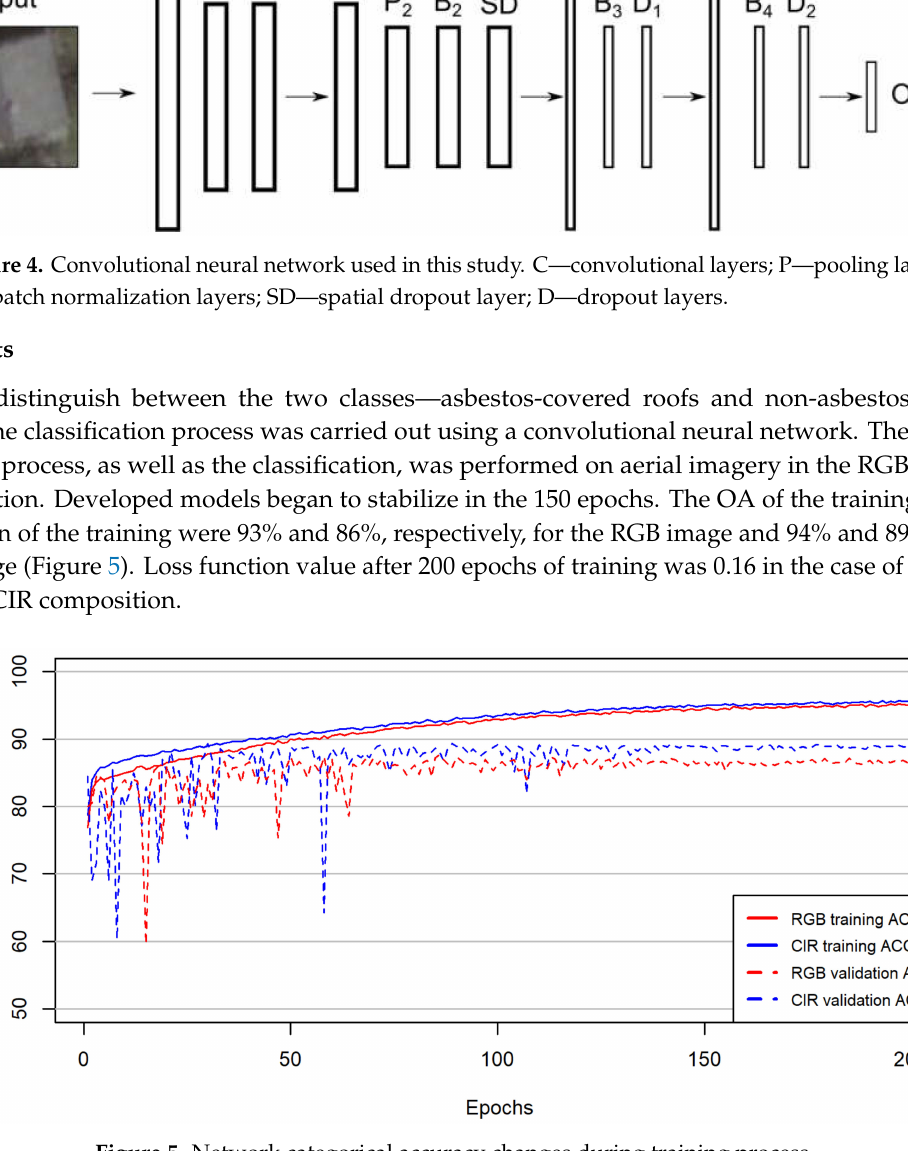
Figure 5. Network categorical accuracy changes during training